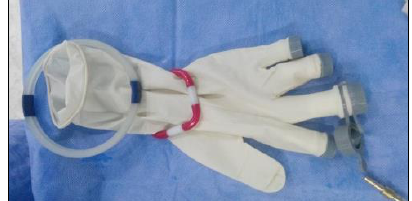
Figure 1:- Homemade device used in LESS proce- dures: The surgical glove port.